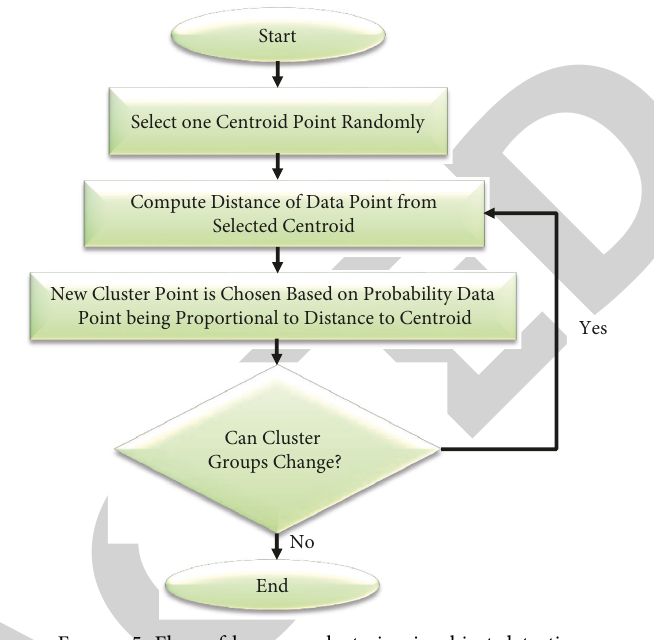
Figure 5: Flow of k-means clustering in object detection.